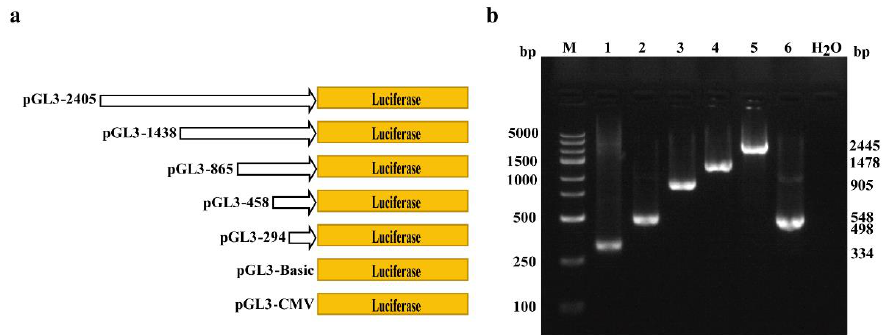
Figure 3. Construction of luciferase reporter vectors with different lengths of porcine COL1A1 promoter. ( a ) Schematic diagram of the luciferase vectors with different lengths of porcine COL1A1 promoters (294–2405 bp) and control vectors (pGL3-CMV and pGL3-Basic); ( b ) M, DL250 maker; lane 1, 2, 3, 4, 5, and 6 represent the PCR products of insert fragments in the pGL3-294, pGL3-458, pGL3-865, pGL3-1438, pGL3-2405, and pGL3 – CMV vectors, respectively.